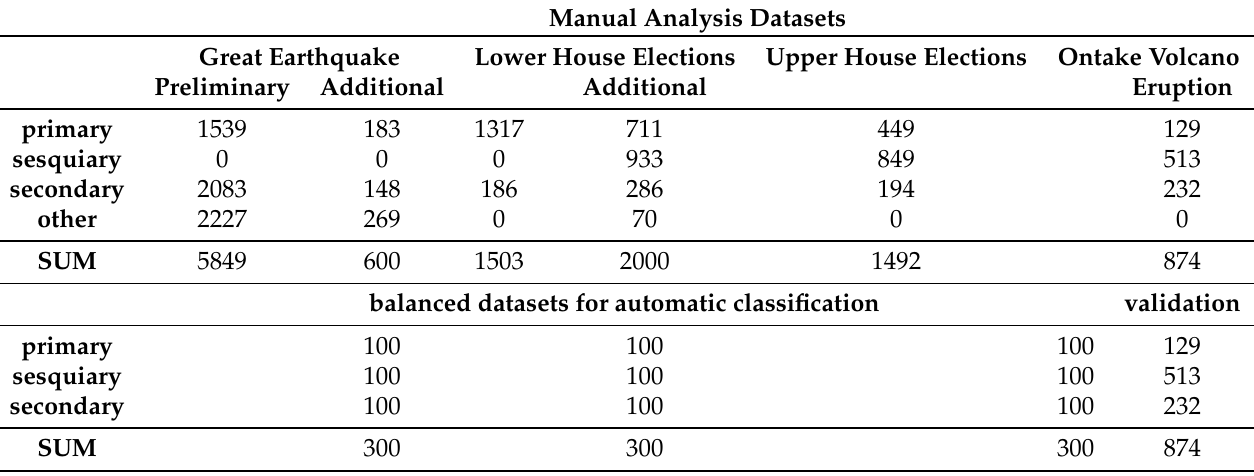
Table 6. Outline of all datasets applied in this